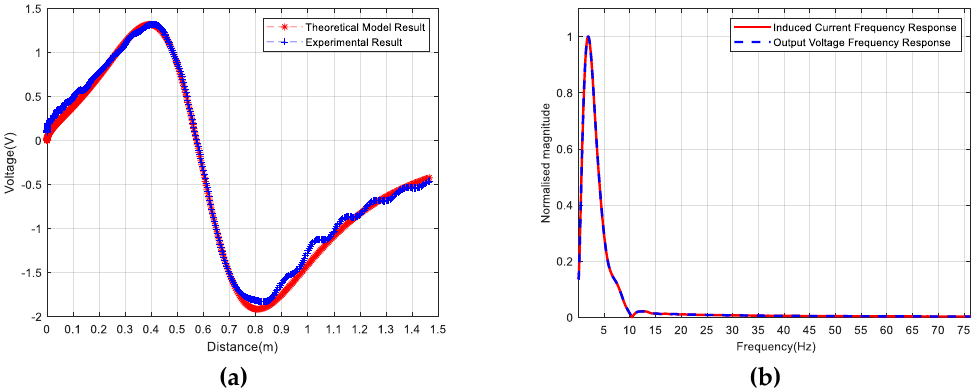
Figure 22. Comparison of the theoretical and measured signal comparison: ( a ) Time domain waveform, and ( b ) spectrum.